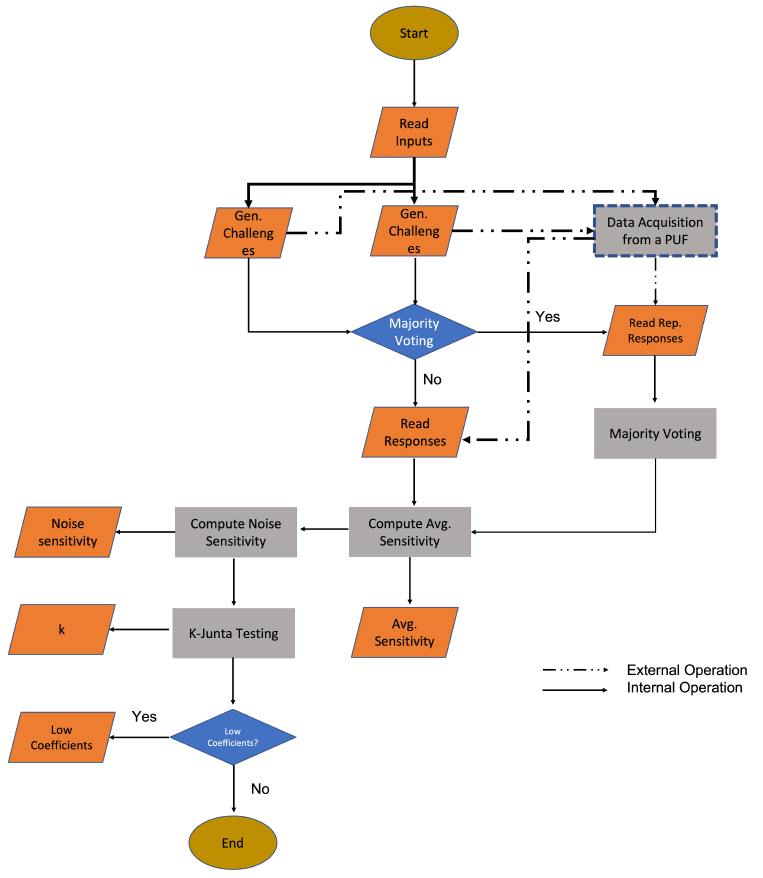
Figure 8. The workflow of PUFmeter